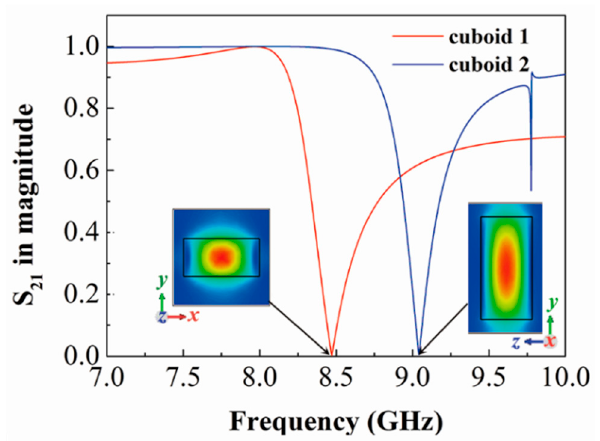
Figure 4. Simulated transmission spectra of the two single cuboids. The left inset is the schematic magnetic field | H | of cuboid 1 at 8.47 GHz, and the right inset is that of cuboid 2 at 9.04 GHz. The incident polarization is in the x direction.